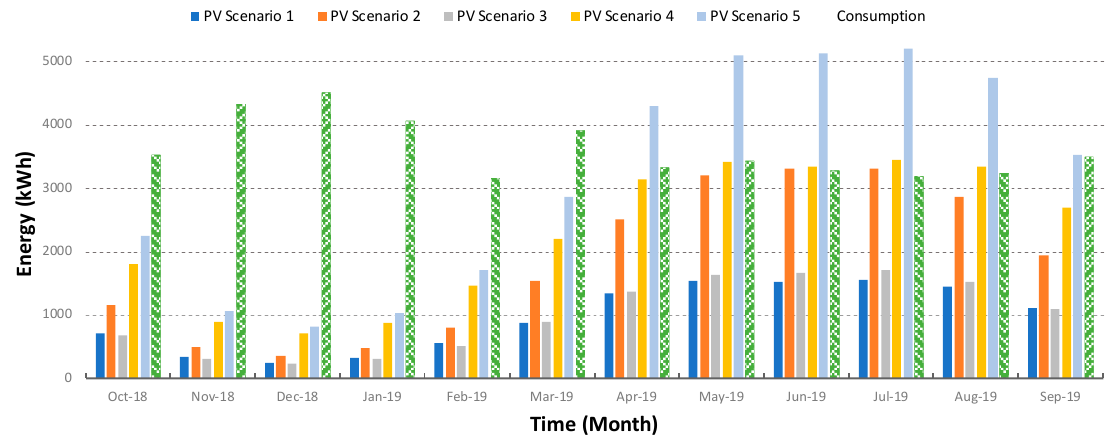
Figure 11. Monthly PV energy generations versus load Figure 11. Mo nthly PV energy generations versus load consumption.